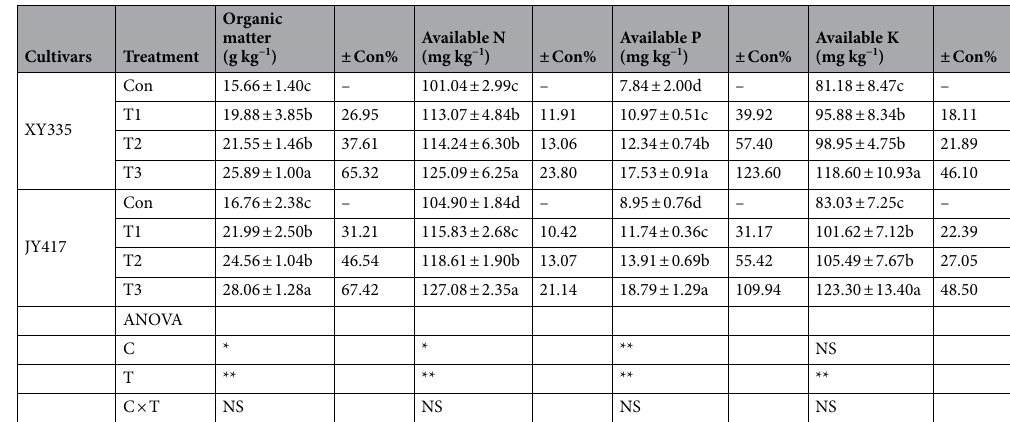
Table 2. Influence of T. asperellum on the nutrient contents of maize seedling rhizosphere soil (± SD). Con, T1, T2, and T3 indicate 0, 1 × 10 3 , 1 × 10 6 , 1 × 10 9 spores L −1 suspension, respectively. Soil nutrient contents were measured on the 27th day after T. asperellum application. C and T indicated cultivars and treatments, respectively. Different letters within a column represented significant difference at 5% probability level, and the numerical value indicated the mean value of five repeats. Differences between treatments were calculated for each particular cultivar. NS, not significant. * and **, significant at the 0.05 and 0.01 probability level, respectively.